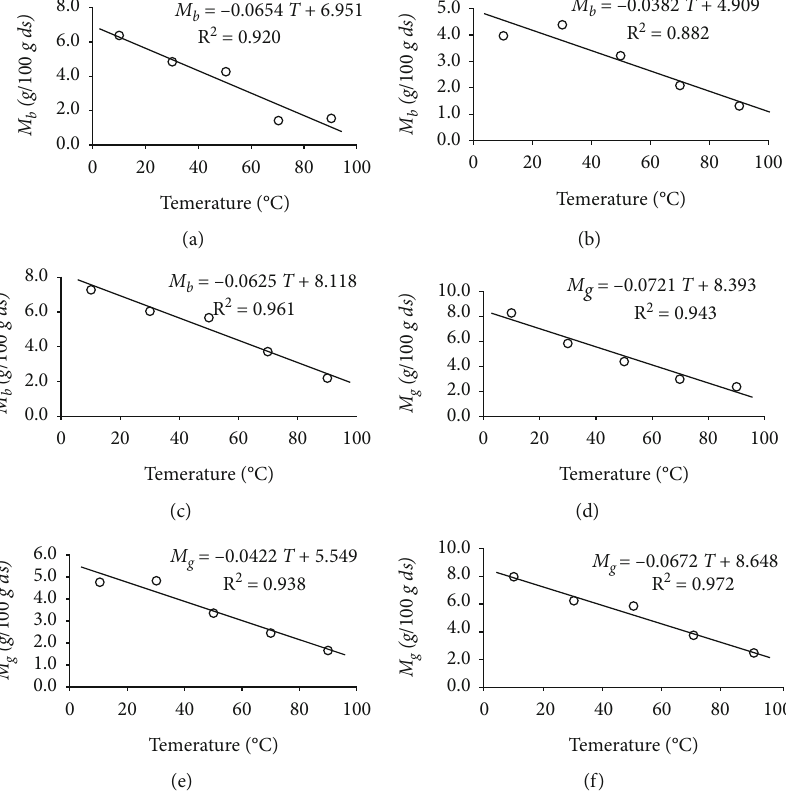
Figure 6: BET ((a) cellulose, (b) lignin, and (c) hemicellulase) and GAB ((d) cellulose, (e) lignin, and (f) hemicellulase) monolayer values as a function of temperature.